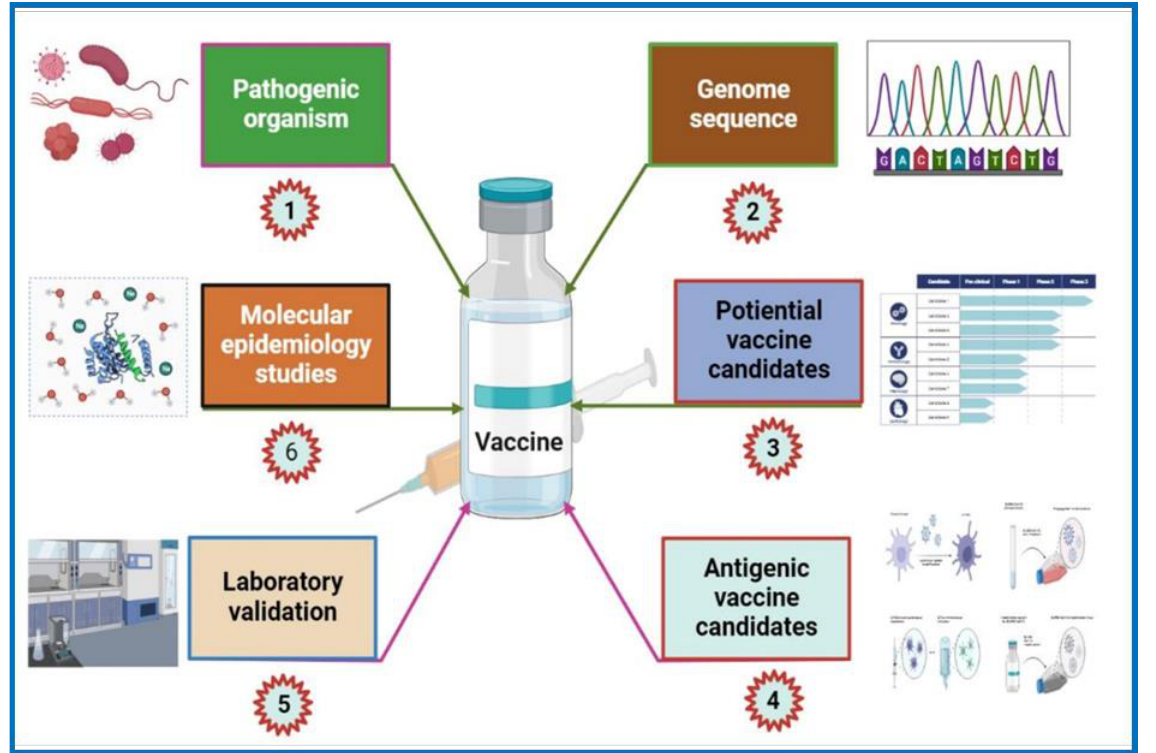
Figure 2. Flow chart of the reverse vaccinology approach for vaccine development. The RV approach begins with the genomics of pathogenic microorganisms using computational analysis based on the algorithms obtained from experimental biological data. Surface-associated and secretory pro- teins (SASPs) and virulence factors are examples of potential vaccine candidates. These are then subsequently examined to find protein candidates with B cell and T cell antigenic epitopes. The identified proteins are then PCR amplified and expressed in a vector. Further validation of these pro- teins includes purification followed by testing via animal models for immunogenicity. Furthermore, resulting from various experimental testing (FACS, Western blotting, serum bactericidal activity, etc.) on the animal model sera, a potential protein candidate provoking bactericidal antibodies is picked. The selected candidate undergoes a pre-clinical stage, followed by molecular epidemiological studies, and then enters into clinical trials. If the candidate shows promising results, then it undergoes the production process. The figure was generated using BioRender software (biorender.com (accessed on 12 December 2022) and published under license agreement number